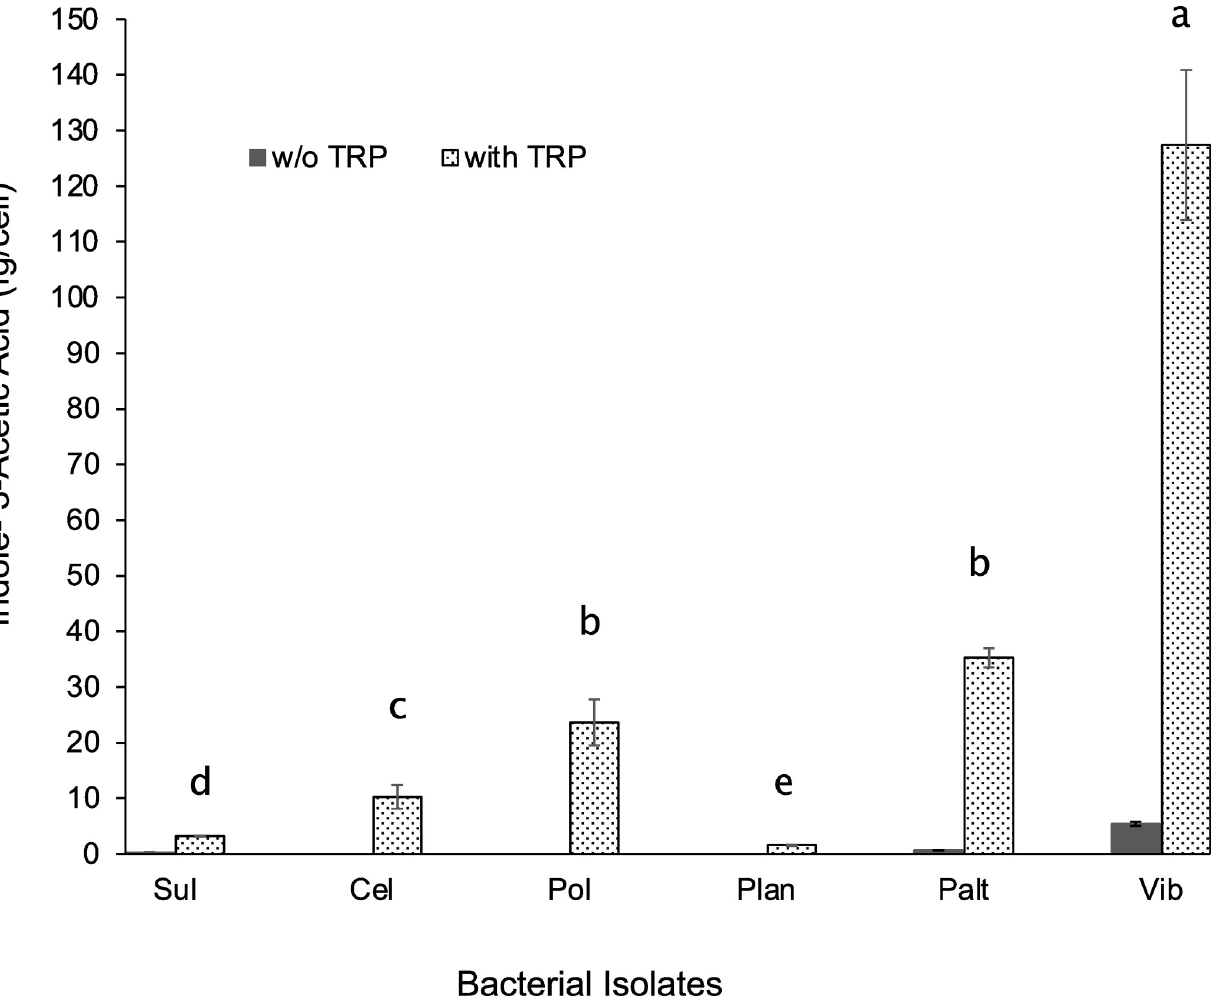
Fig 6. Indole acetic acid (IAA) secretion of bacterial isolates in the absence and presence of the IAA precursor tryptophan (TRP). Sul- Sulfitobacter ; Cel- Cellulophaga ; Pol- Polaribacter ; Plan- Planococcus ; Palt- Pseudoalteromonas ; Vib- Vibrio . Data (n = 3 for each treatment) were log-transformed and analyzed using one-way ANOVA, followed by pairwise comparisons using Tukey-HSD. The letters above each column indicate statistically different IAA production (Tukey HSD, p < 0.05).